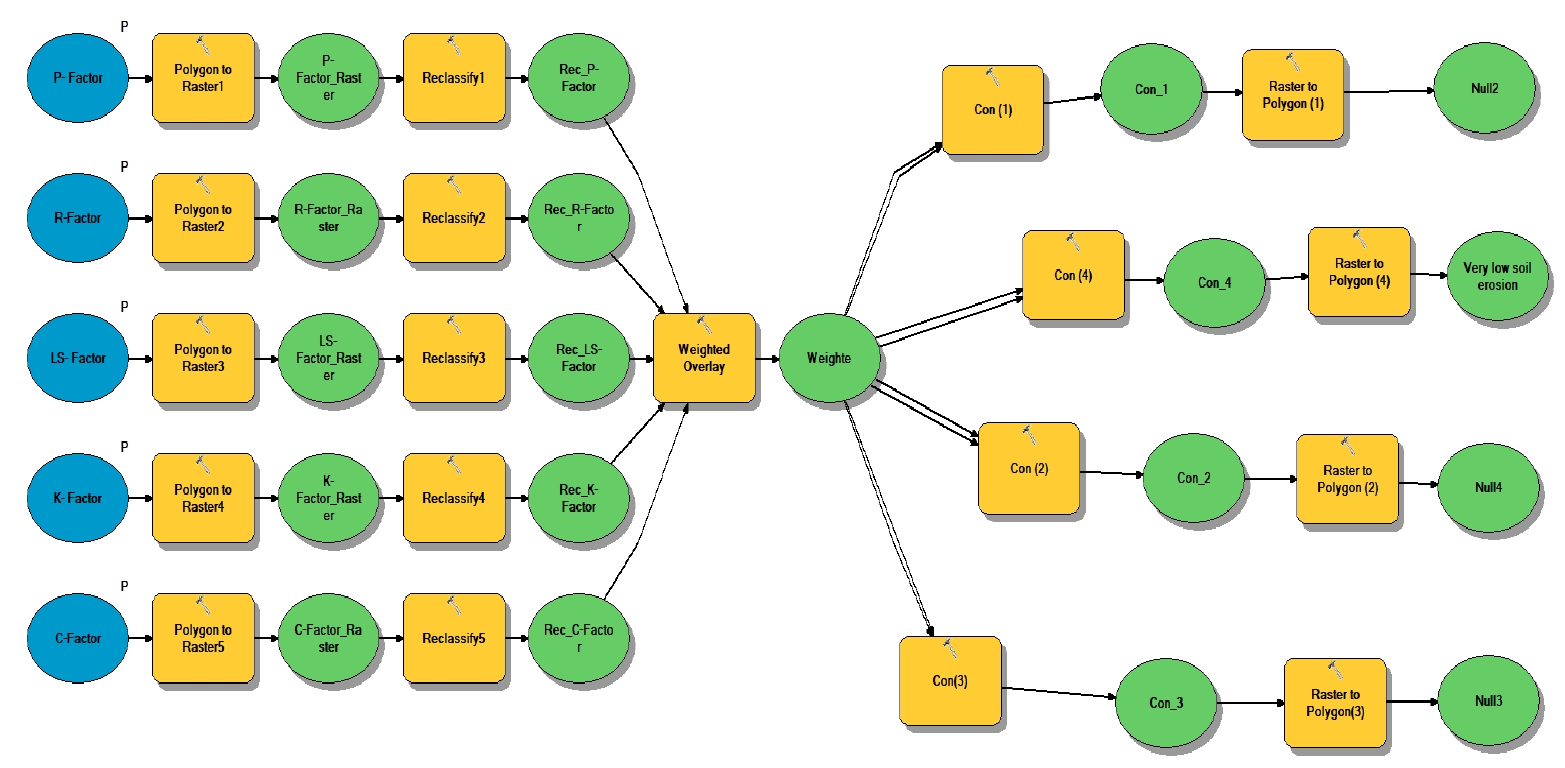
Figure 4. A flowchart of the proposed spatial-based model (SSLM) design steps according to the USLE model.